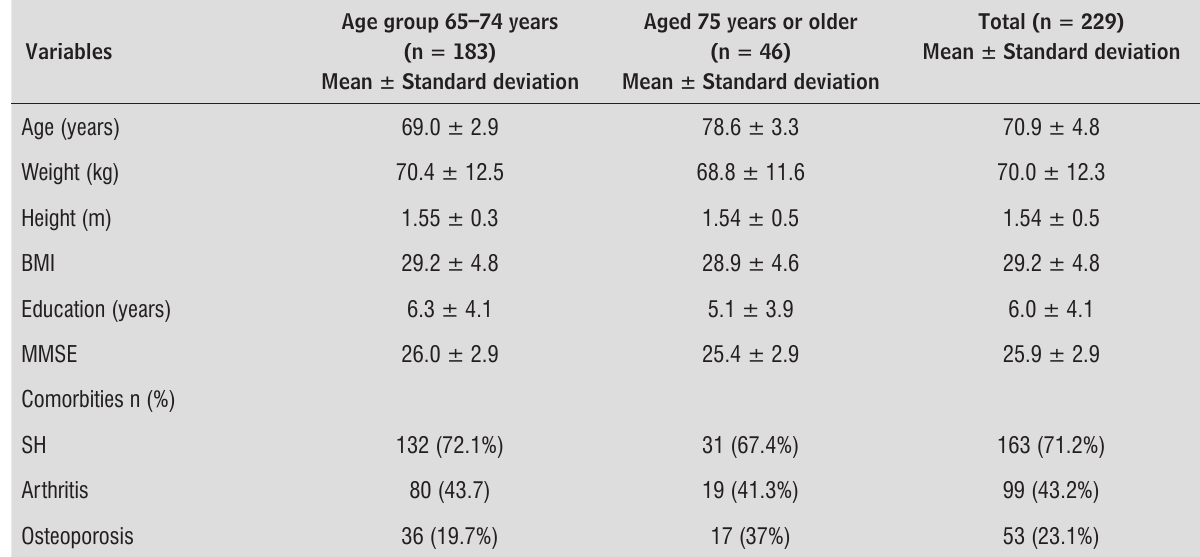
Table 1 - Demographic and clinical sample characteristics (n =